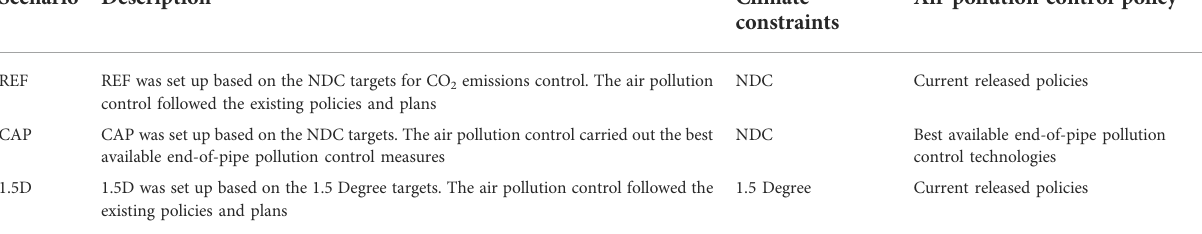
TABLE 1 Scenario setting and description in this study. Scenario